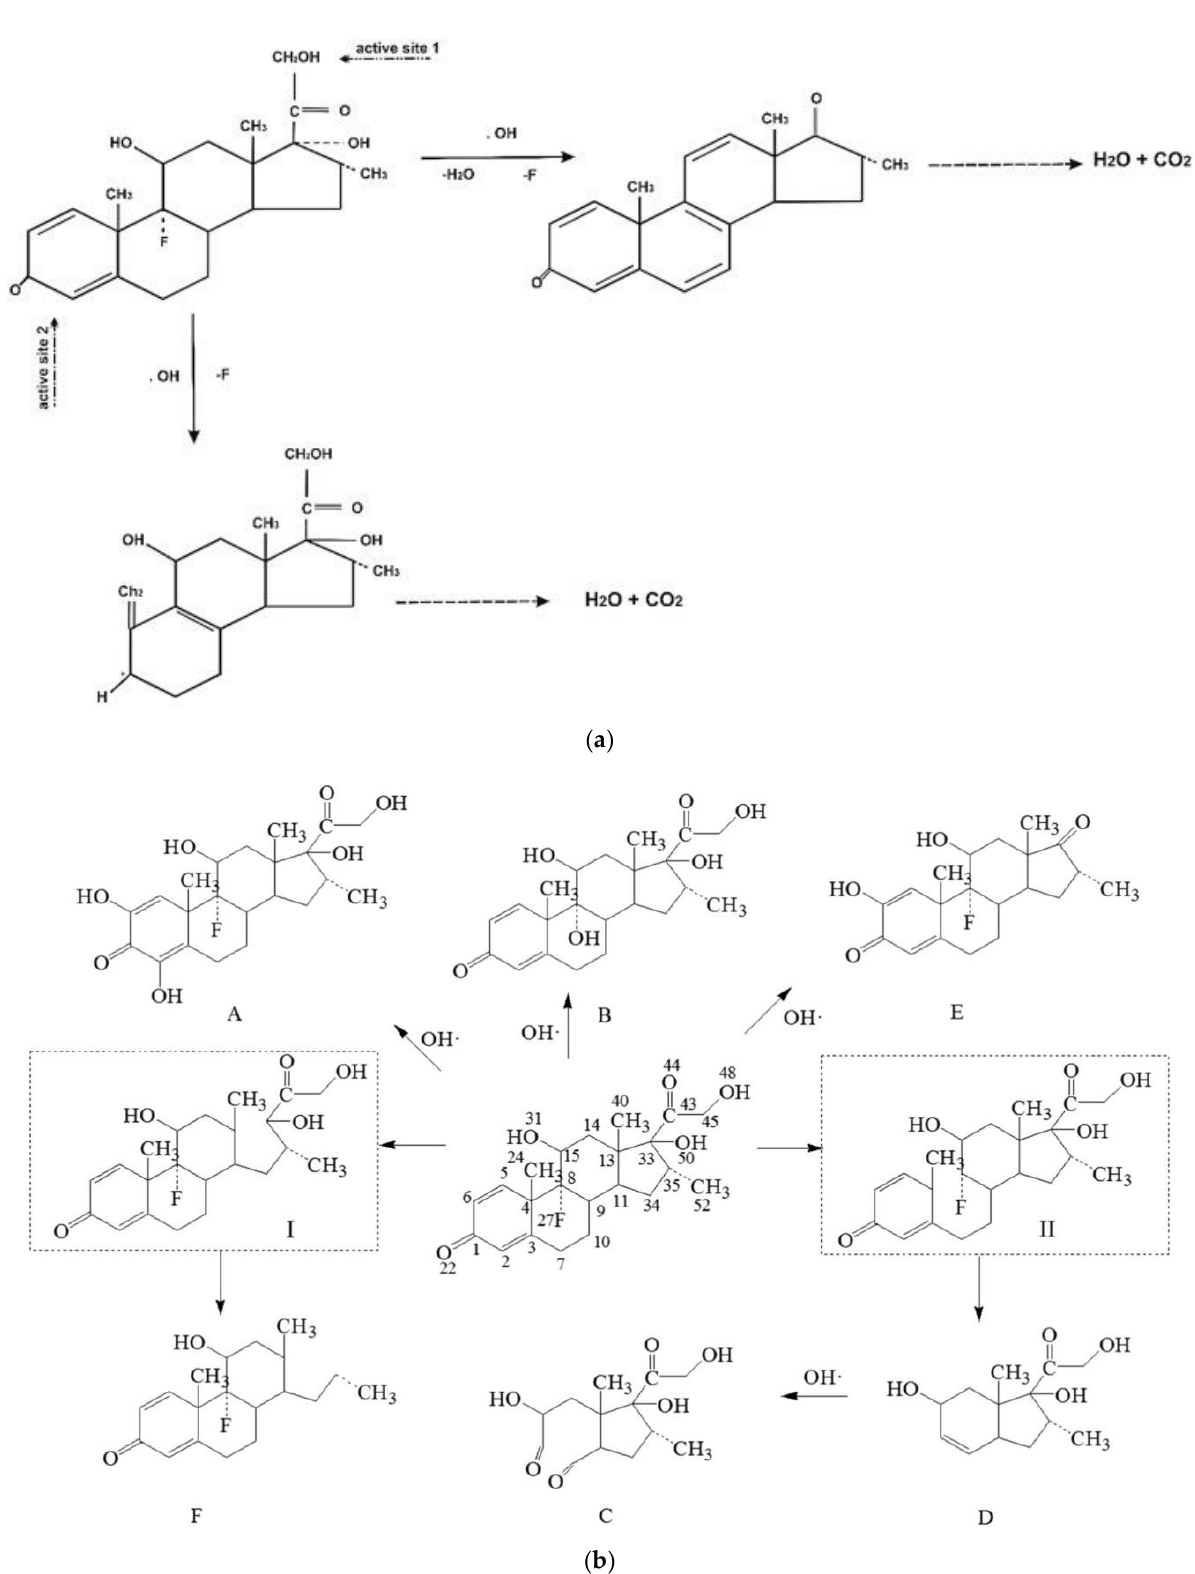
Figure 3. Degradation pathways of DEXA using advanced oxidation processes: ( a ) photocatalysis system using nTiO 2 [132], and ( b ) gamma irradiation [48].